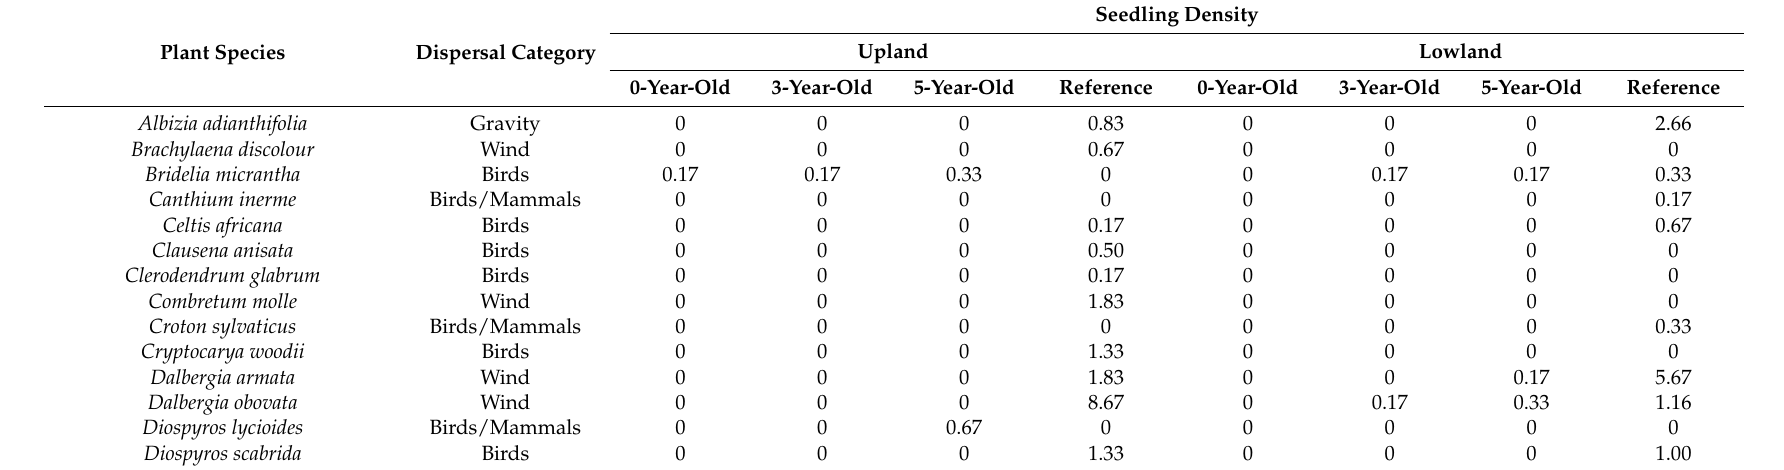
Table 4. Mean woody seedlings density (seedlings or saplings per 4 m 2 ) and their dispersal agent categories across habitats.